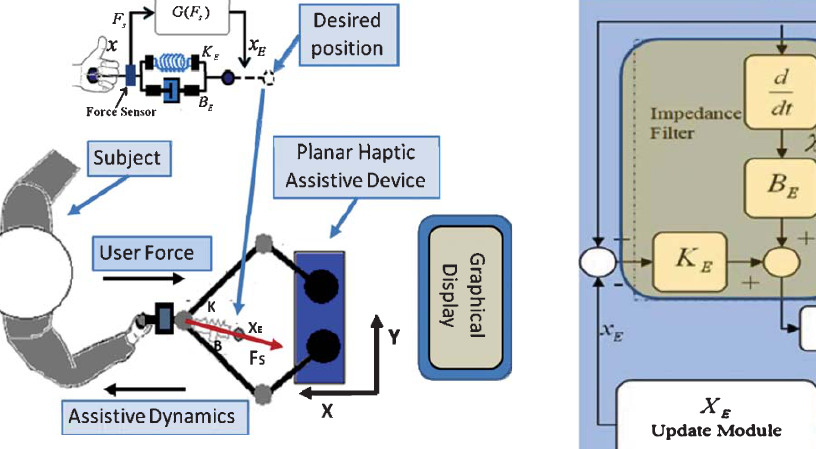
Fig. 4. System assistive mode setup.